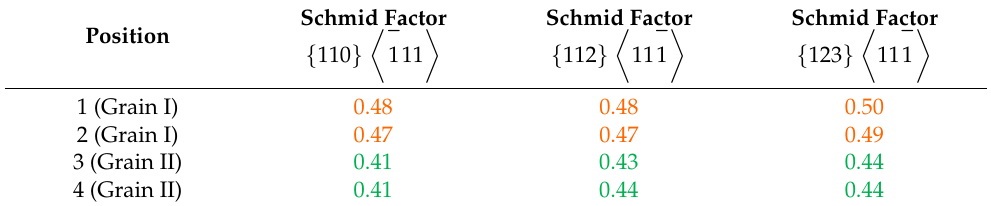
Table 5. Schmid factors (F||Y) of the active slip systems from positions 1–4, illustrated in Figure 11.